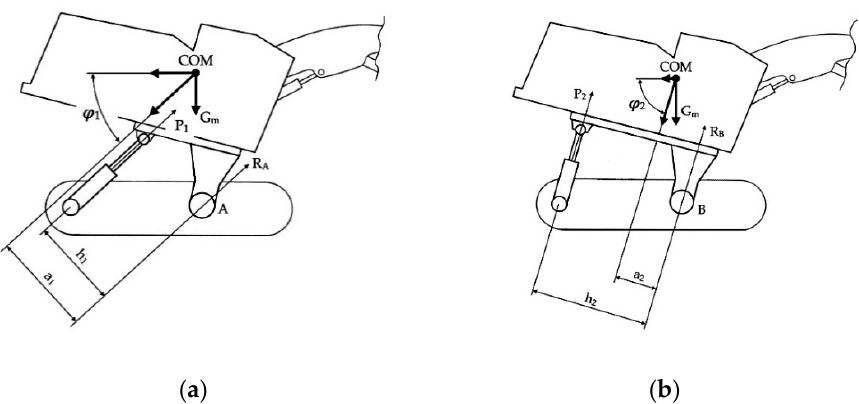
Figure 1. The leveling system layout: ( a ) with the two-cylinder system; ( b ) with a three-cylinder system.